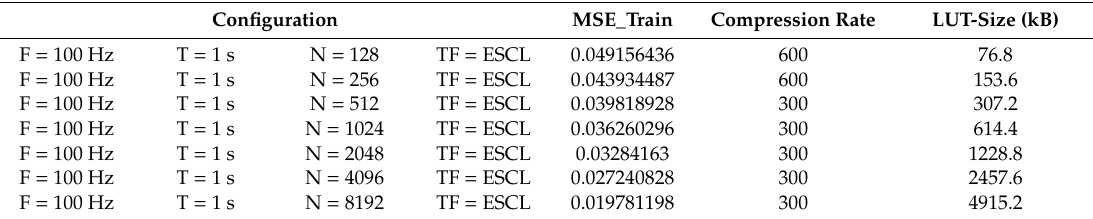
Table 2. Evaluating the codebook size N for the model (TF = ESCL, F = 100 Hz and T = 1